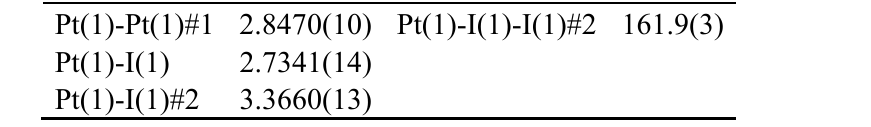
Table 2. Selected bond length (Å) and angles (°) for 1